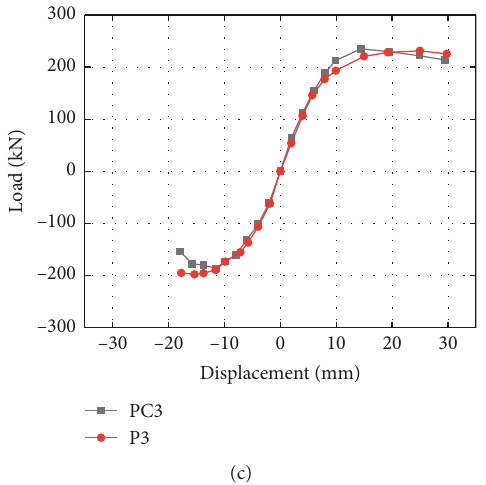
Figure 14: Comparison of skeleton curves between numerical analyses and experimental